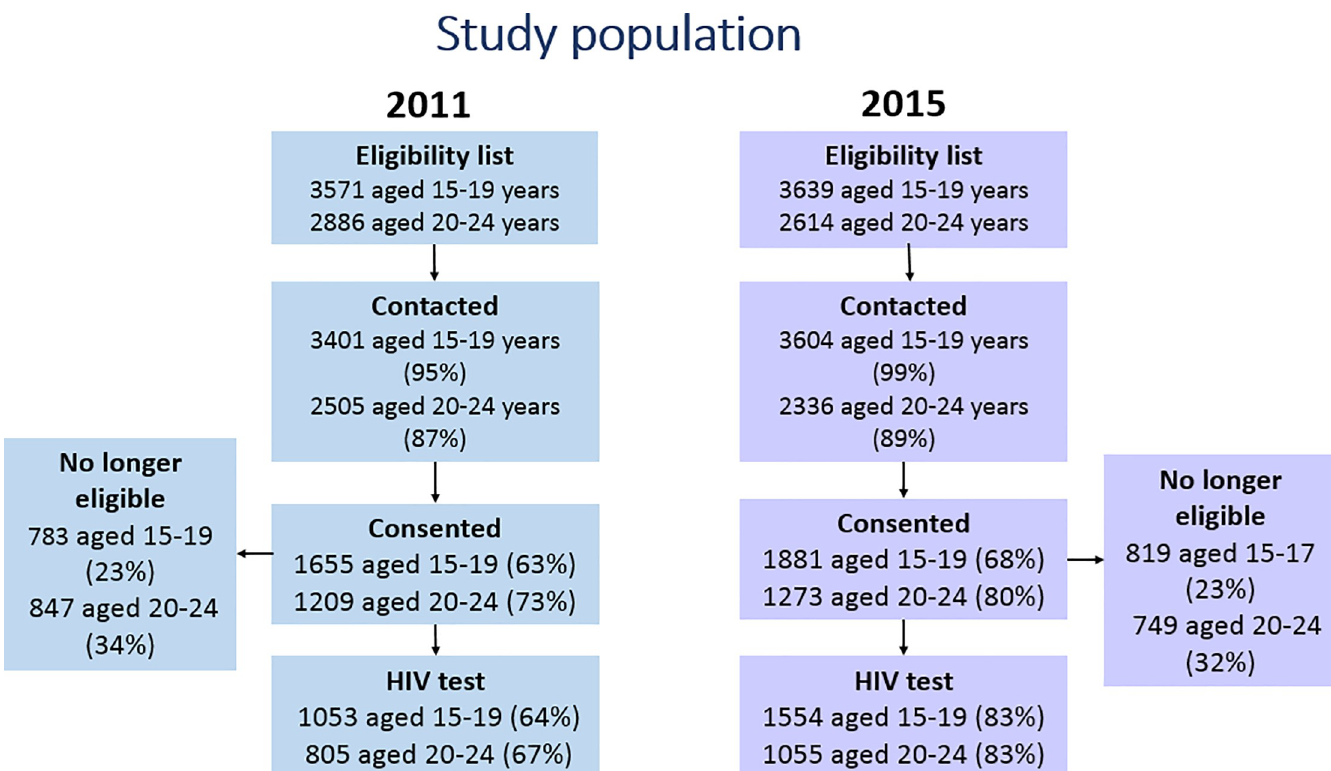
Fig 2. Showing the participation rates of AGYW in the two-time